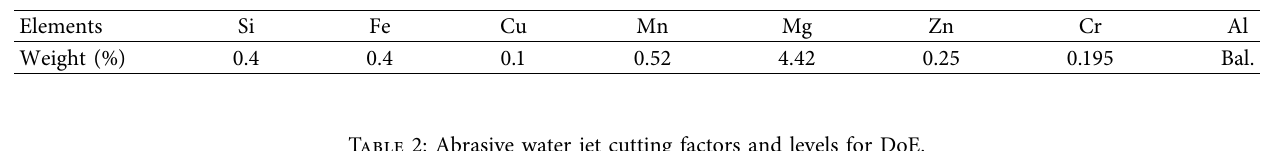
Table 1: Composition of